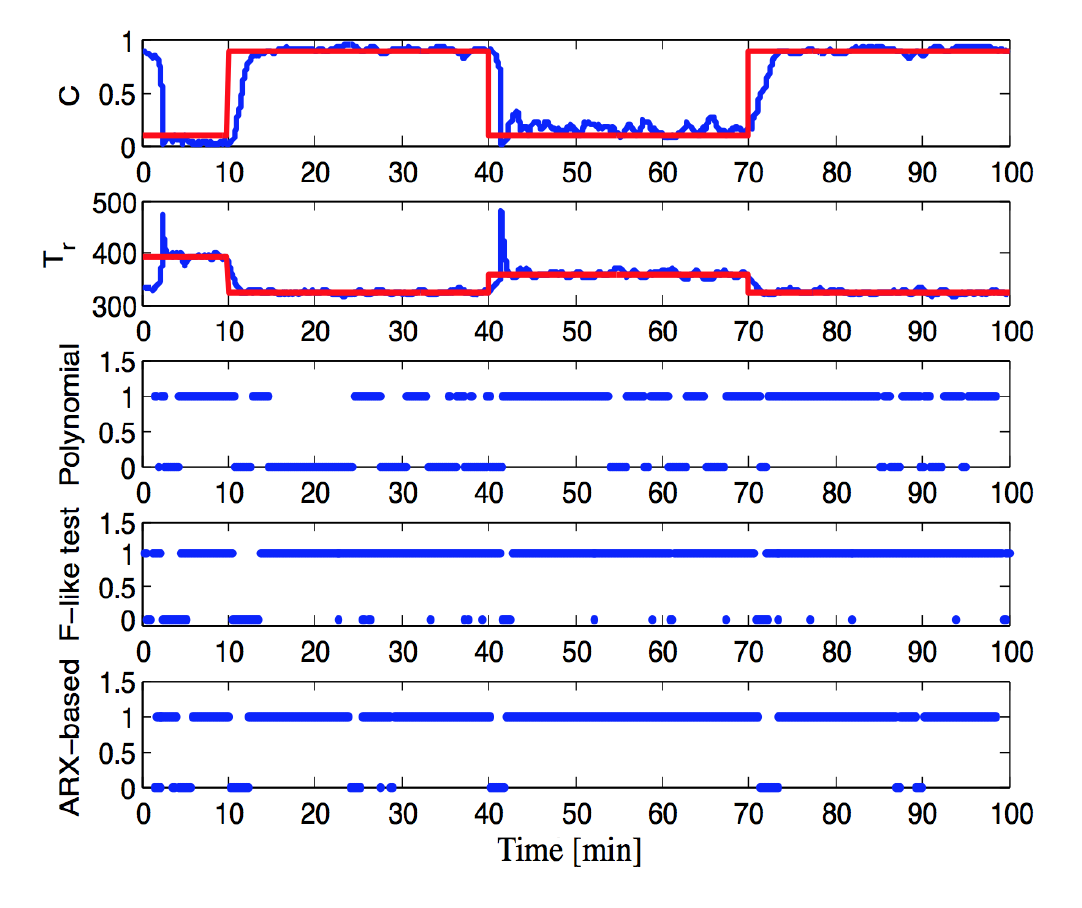
Figure 10. CSTR data results with 3% of noise, in which a window of 30 was used for the polynomial and the ARX-based